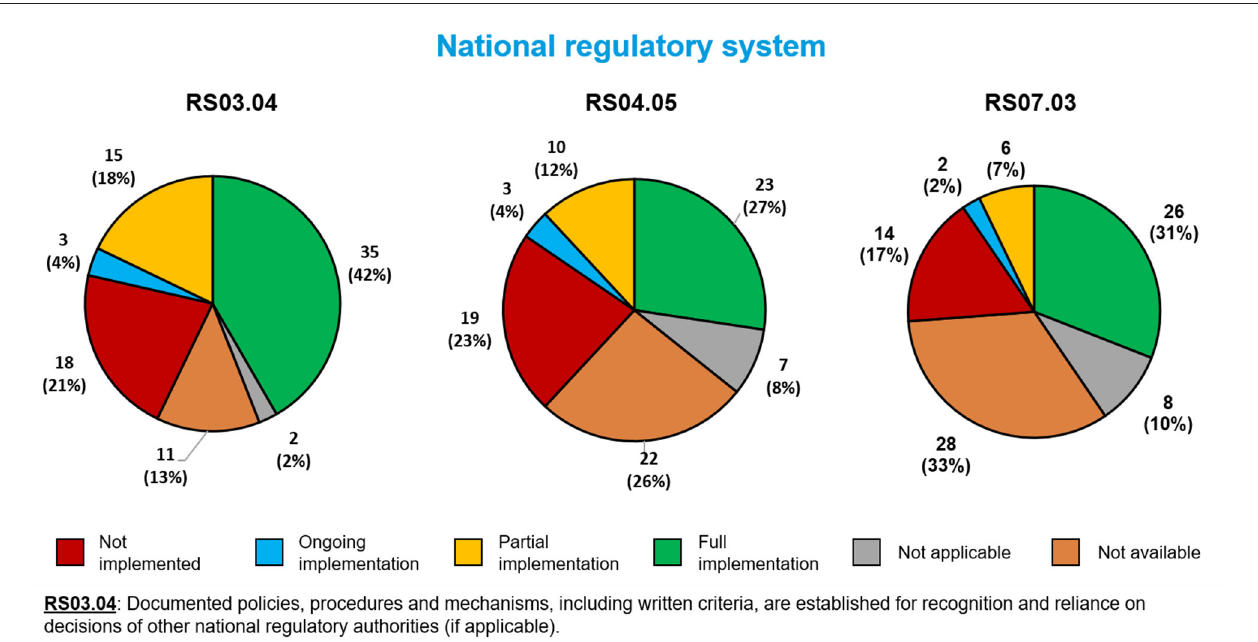
FIGURE 2 | Implementation of three WHO Global Benchmarking Tool sub-indicators related to the overall functioning of a national regulatory authority in public health emergencies, among 84 Member States benchmarked from 2016 to